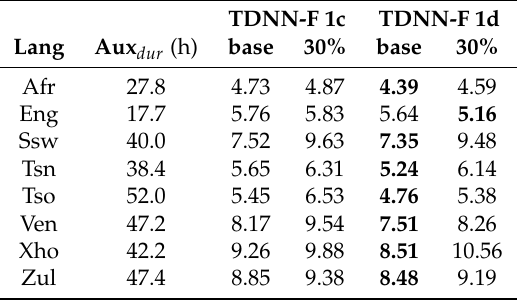
Table 8. PERs for TDNN-F baseline (base) and 30% PER selection criterion systems per language (lowest PERs in bold).